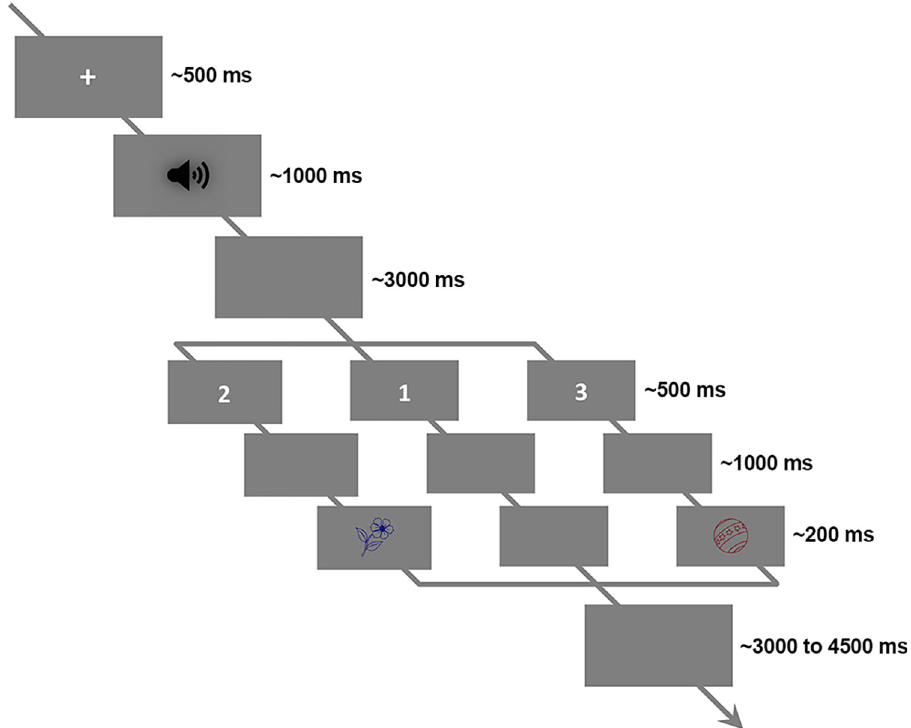
Fig 9. Experimental procedure. An illustration of the experimental procedure. Participants were asked to looking at the screen center, after hearing the speech stimulus they would do a task indexed by a number that showed on the screen. If the number was “1,” they would judge whether the heard stimulus was a phrase or a sentence. If the number was “2,” they would see a following picture then judge whether the color of the picture was the same as the color that described in the speech stimulus. If the number was “3,” they would do an object matching task, in which they would judge whether the object of the picture was the same as the object that described in the speech stimulus. Trial type was pseudo randomly assigned throughout the whole experiment. The figure was originally created by Fan Bai, which permits unrestricted use and distribution. Available from: